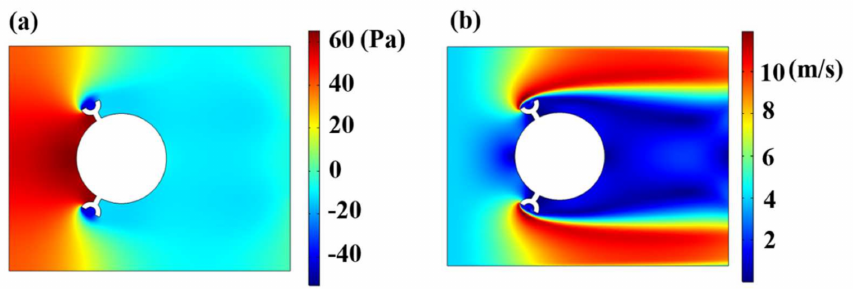
Figure 4. 2D flow field simulation of a bluff body with curve-shaped attachments: ( a ) pressure field and ( b ) velocity